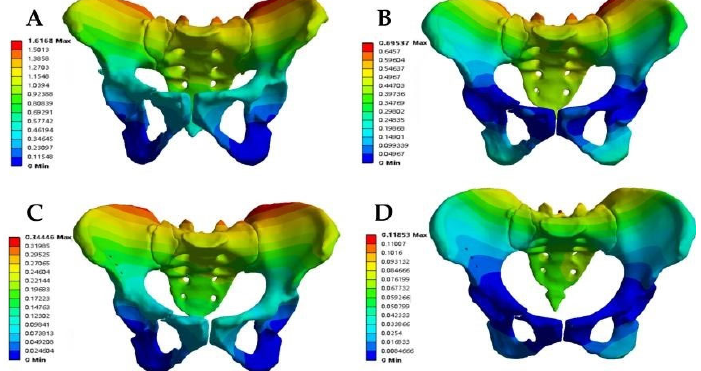
Figure 3. The maximum total displacement in Tile b2 pelvic fracture under different fixation modes (( A ) anterior ring hollow compression screw sitting group; ( B ) anterior ring hollow compression screw standing group; ( C ) anterior ring plate sitting group; ( D ) anterior ring plate standing group ) Table 3. The maximum displacement (MD) of different finite element models after loading the pelvis.